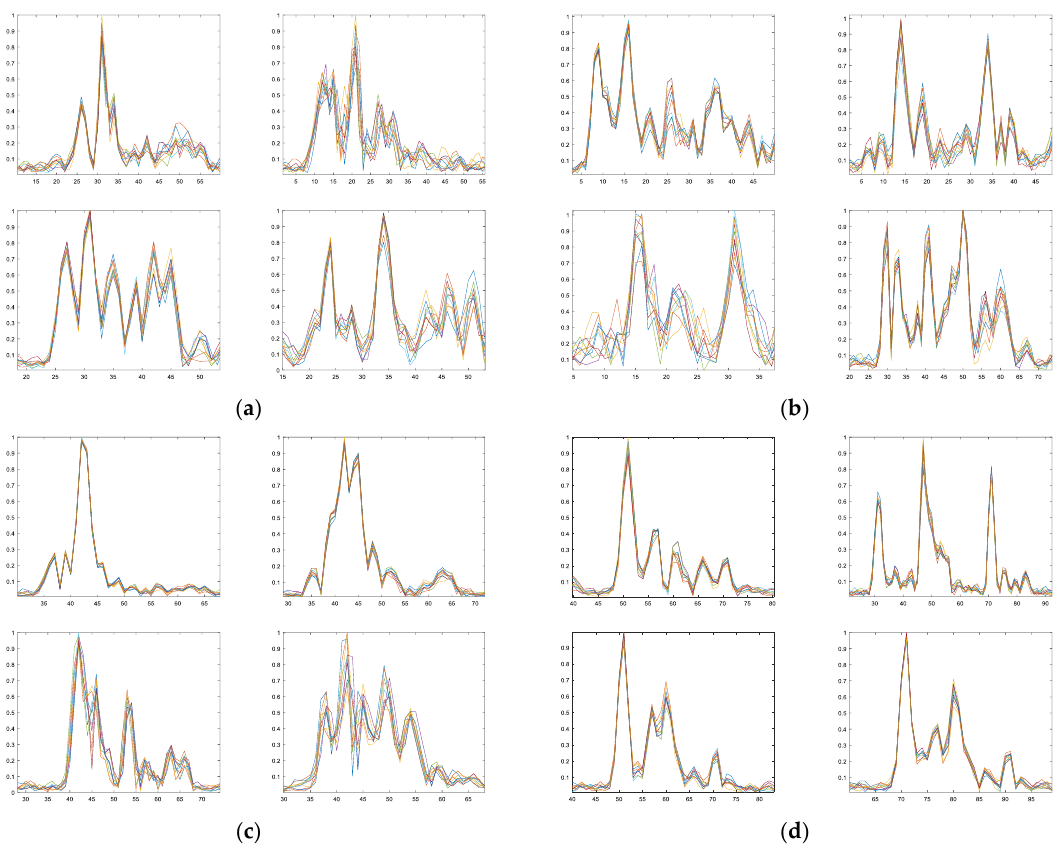
Figure 10. Typical HRRP sequences for the four types of vehicles (CPI = 10). ( a ) Type A; ( b ) Type B; ( c ) Type C; ( d ) Type D. Table 6. Real data recognition result for the SSM-ANM method.